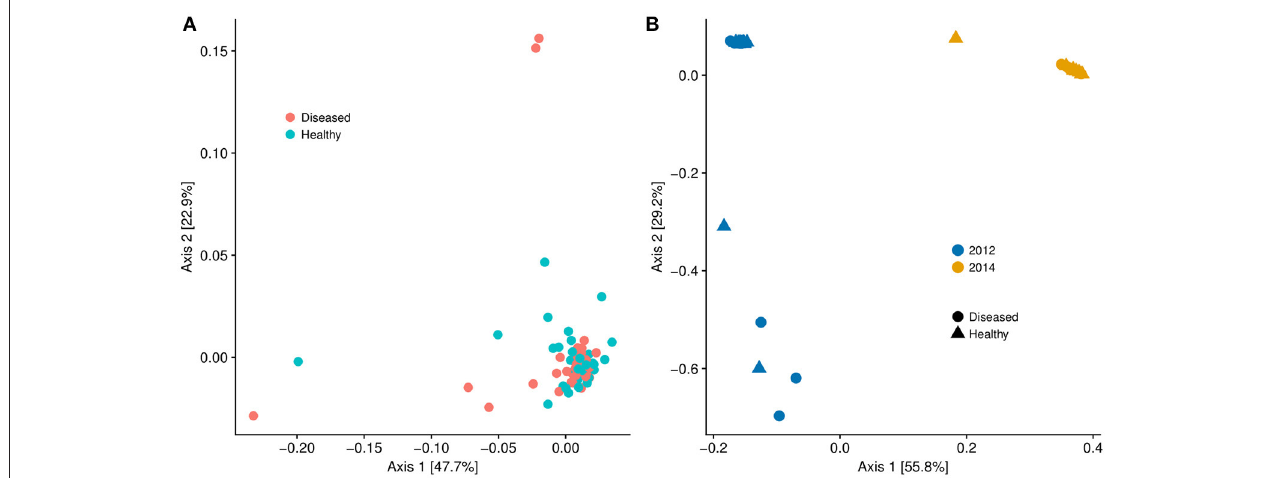
FIGURE 6 | (A) Multidimensional scaling graph of beta diversity of microbial communities of Siderastrea siderea samples broken into diseased and healthy groups. The microbiome of the diseased corals was statistically different from the microbiome of the healthy corals (Adonis, p = 0.01). (B) Multidimensional scaling graph of beta diversity of microbial communities of Siderastrea siderea corals. The 2012 data points were taken from Siderastrea siderea microbial metagenome data from a nutrient-enrichment experiment conducted in August of 2012. The 2014 data points were metagenomes from the current dataset sampled in August of 2014, which was subject to nutrient enrichment and high water temperatures. There was no statistical difference between the diseased and healthy microbiomes in 2012 and 2014, but there was a difference between the 2012 and 2014 samples (Adonis, p <